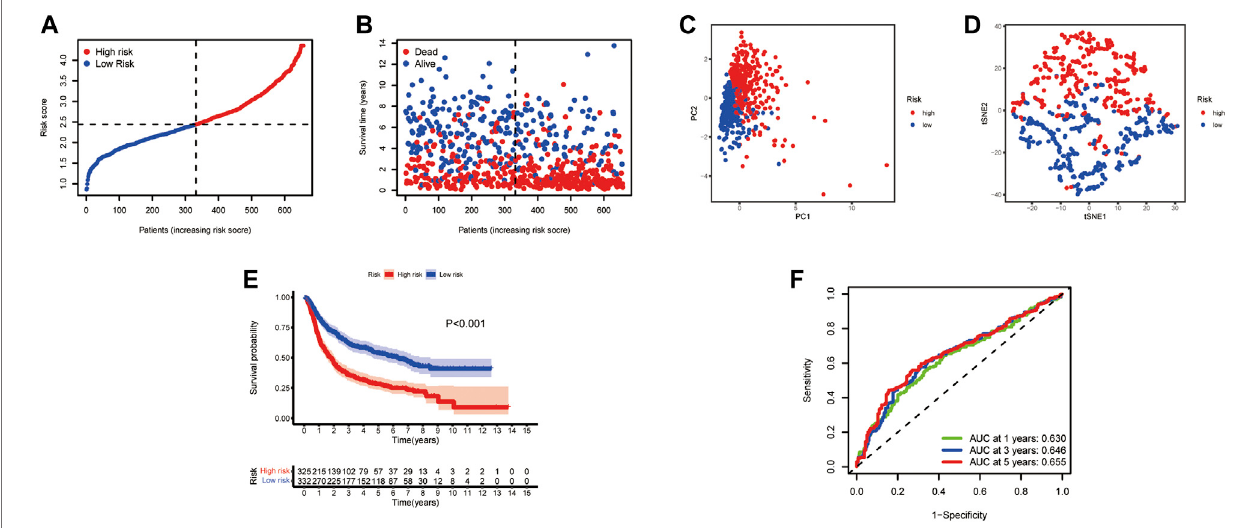
FIGURE 4 | Validation of the risk signature in the CGGA testing set. (A) Patient distribution and median value of CR-Score. (B) Survival time and status distribution by CR-Score. (C) PCA plot of the CGGA cohort. (D) t-SNE plot of the dataset. (E) Kaplan-Meier survival analysis of OS for glioma patients. (F) Time-dependent ROC